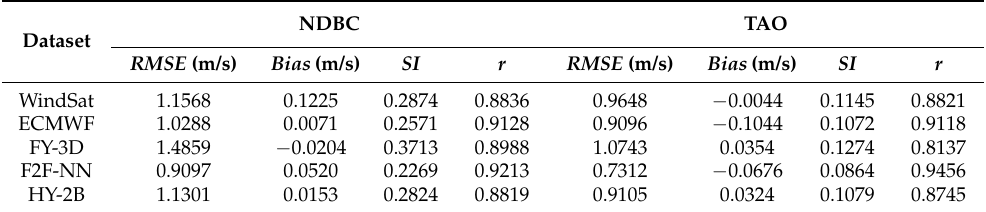
Table 2. The overall comparison results between various wind products and buoy data. Dataset